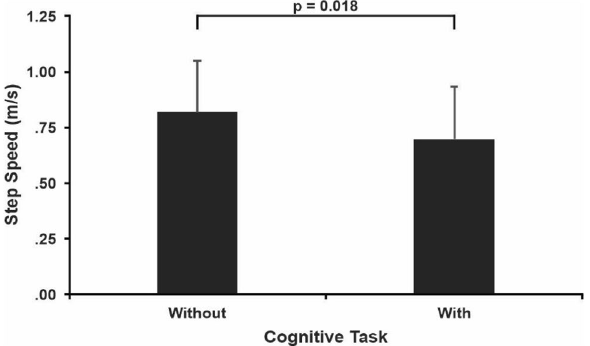
Figure 2. Mean and standard deviation of the cognitive task main effect for the step. The horizontal lines indicate pairwise differences with the respective